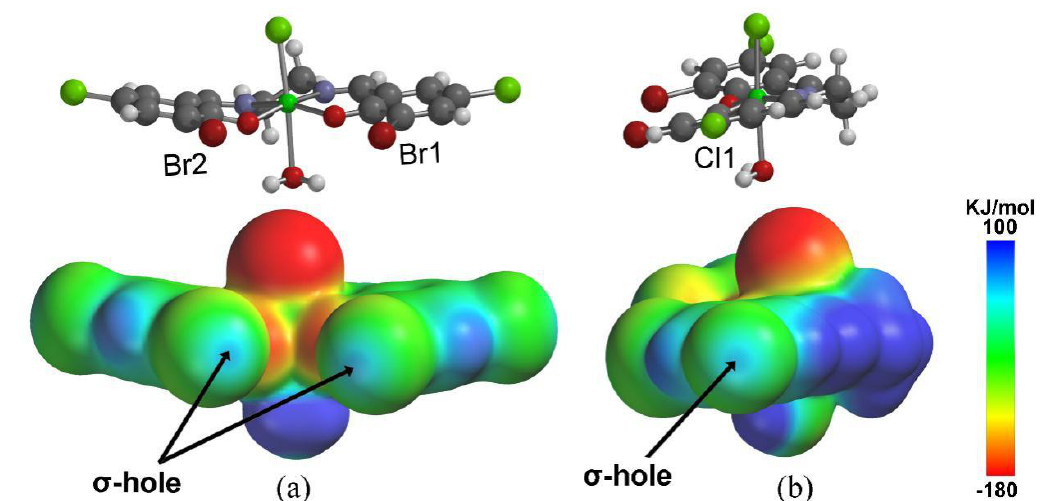
Figure 6. Molecular electrostatic potential calculations of 1, ( a ) σ -hole of bromine atoms ( b ) σ -hole of chlorine atom. Color range (kJ / mol): where red stands for lower than − 140; yellow between − 140 and 100; green between − 30 and 30; and blue greater than 50.